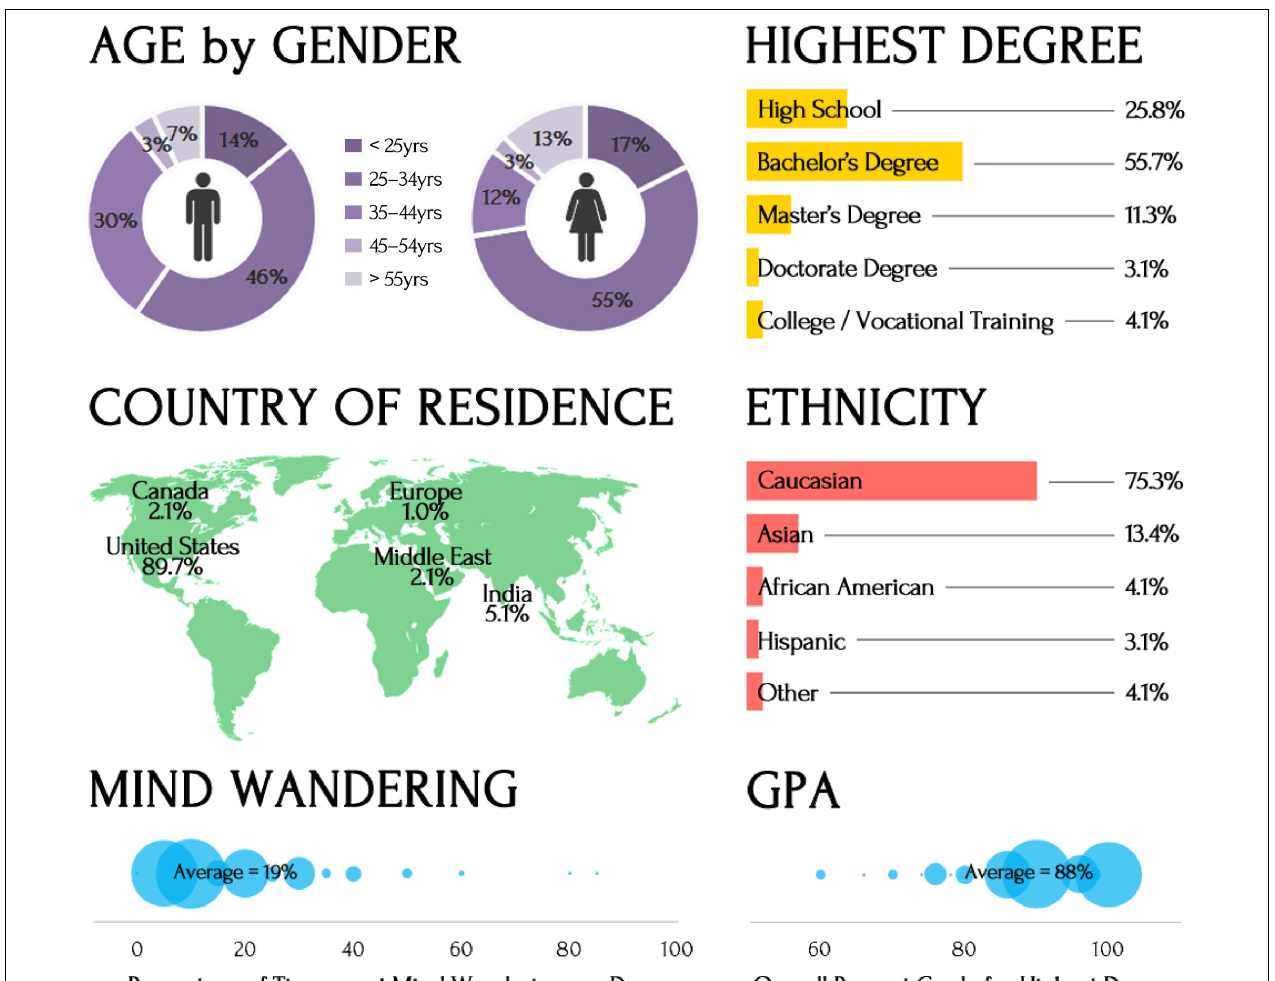
FIGURE 1 | Demographic